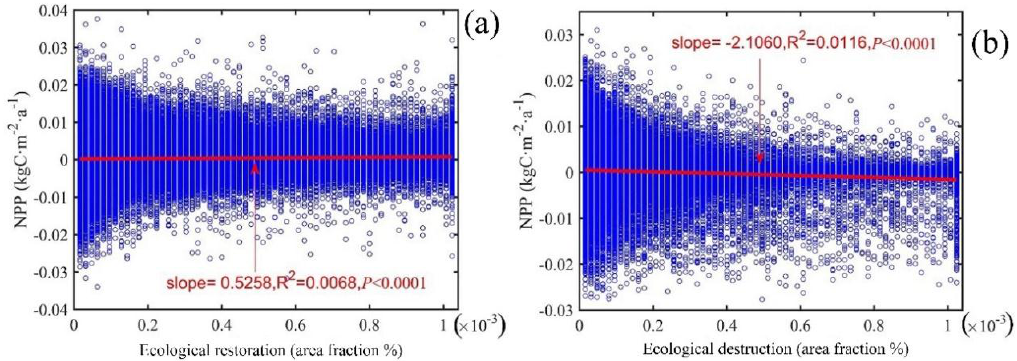
Figure 7. Effects of anthropogenic activities on NPP trends: ( a ) the percentage of ecological restoration; and ( b ) the percentage of ecological destruction.